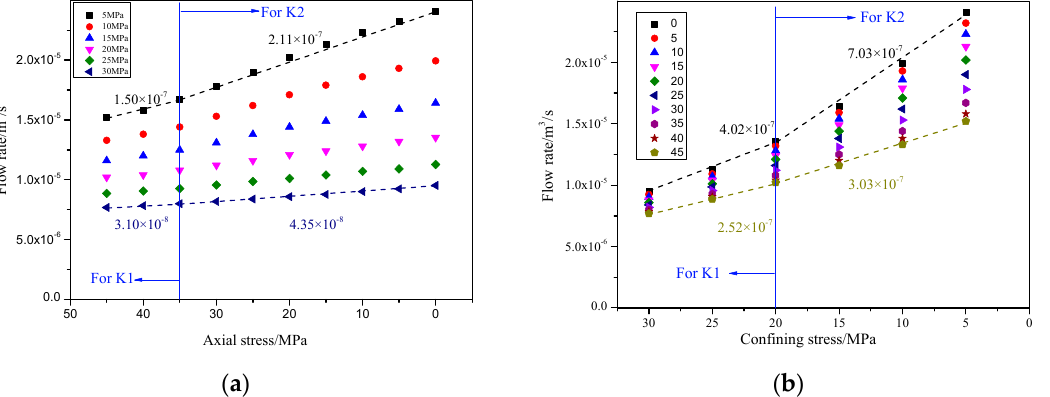
Figure 19. Flow rate change curves with a 70-degree crack: ( a ) variation in flow rate with the axial pressure and ( b ) variation in flow rate with the confining pressure.